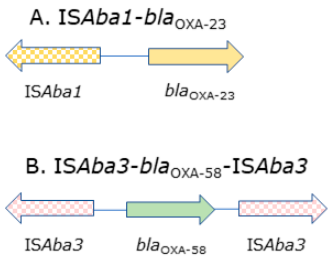
Figure 1. The intrinsic bla CHDL genes with insertion sequence (IS) element clusters found in the following clinical isolates: ( A ) no. 86, 87, 96, 113, 118, 129 and 185; ( B ) no. 43 and 52.